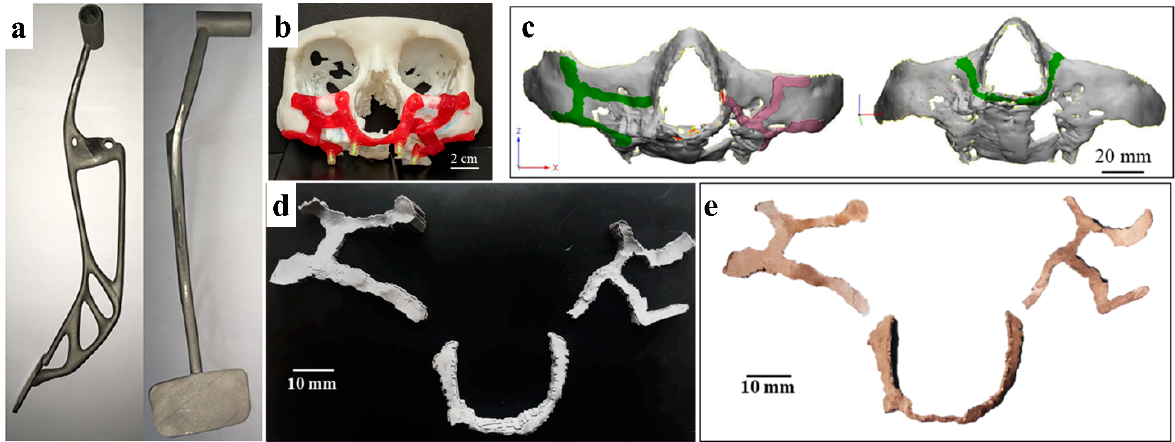
Figure 25. ( a ) 316L MEX brake pedal (Reprinted with permission from ref. [141]. Copyright 2021, Materials Today: Proceedings, Elsevier) and ( b ) maxillofacial implant design, ( c ) maxillofacial implants related to the design, ( d ) as-printed parts following the design and ( e ) as-sintered parts (adapted from [95]).